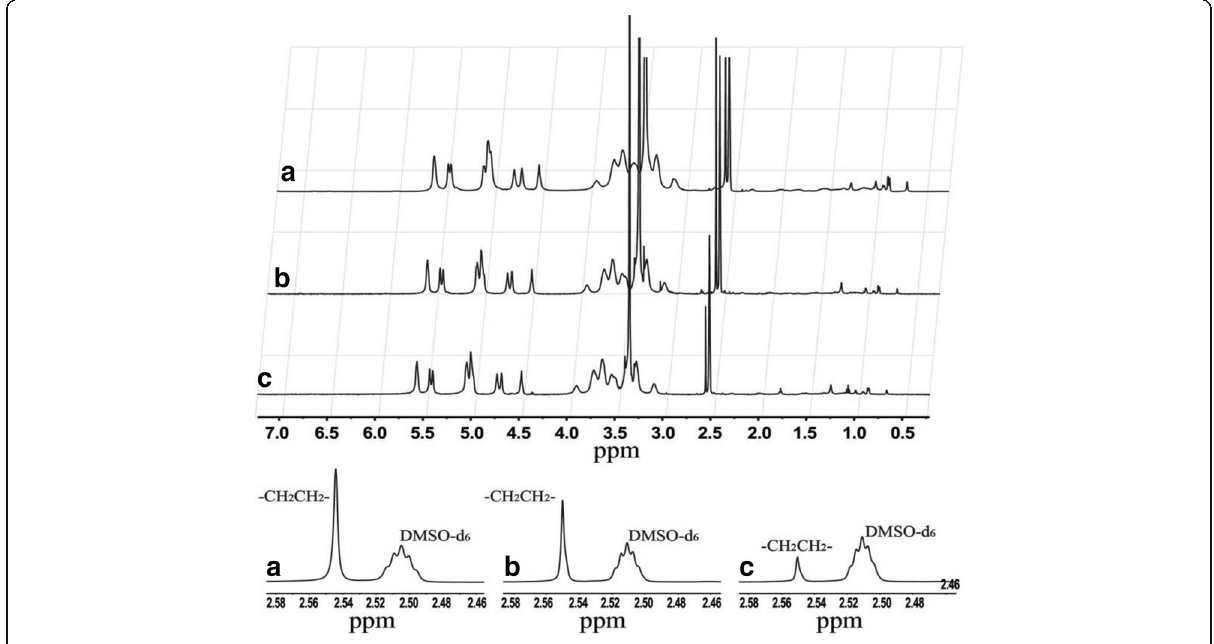
Fig. 1 NMR spectra for CHP-1 ( a ), CHP-2 ( b ), and CHP-3 ( c